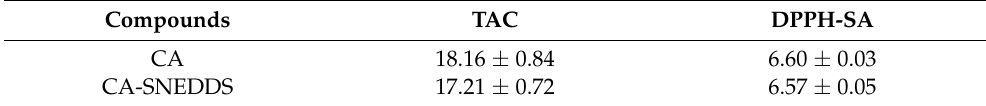
Table 3. Antioxidant activity of the tested